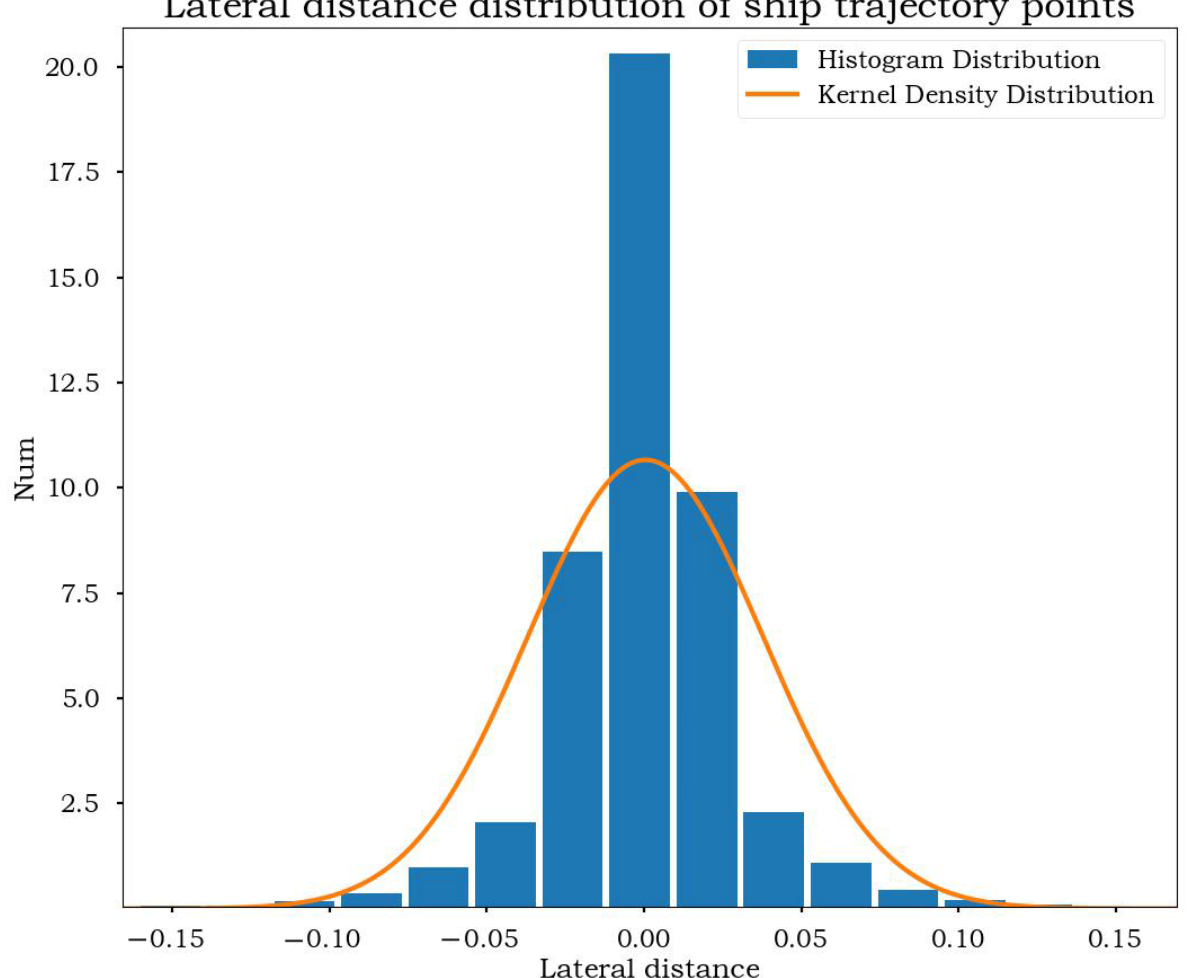
Figure 11. Lateral distance distribution of ship trajectory points.